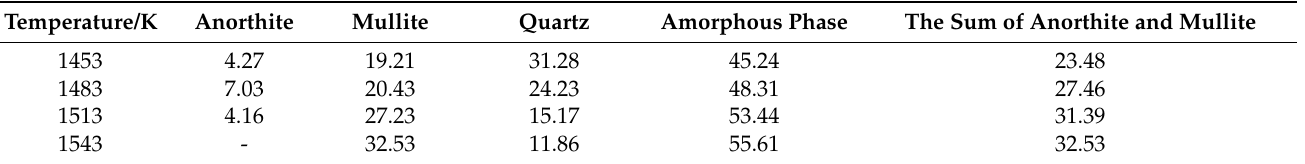
Table 5. Content (wt%) of phase for M at different temperatures.